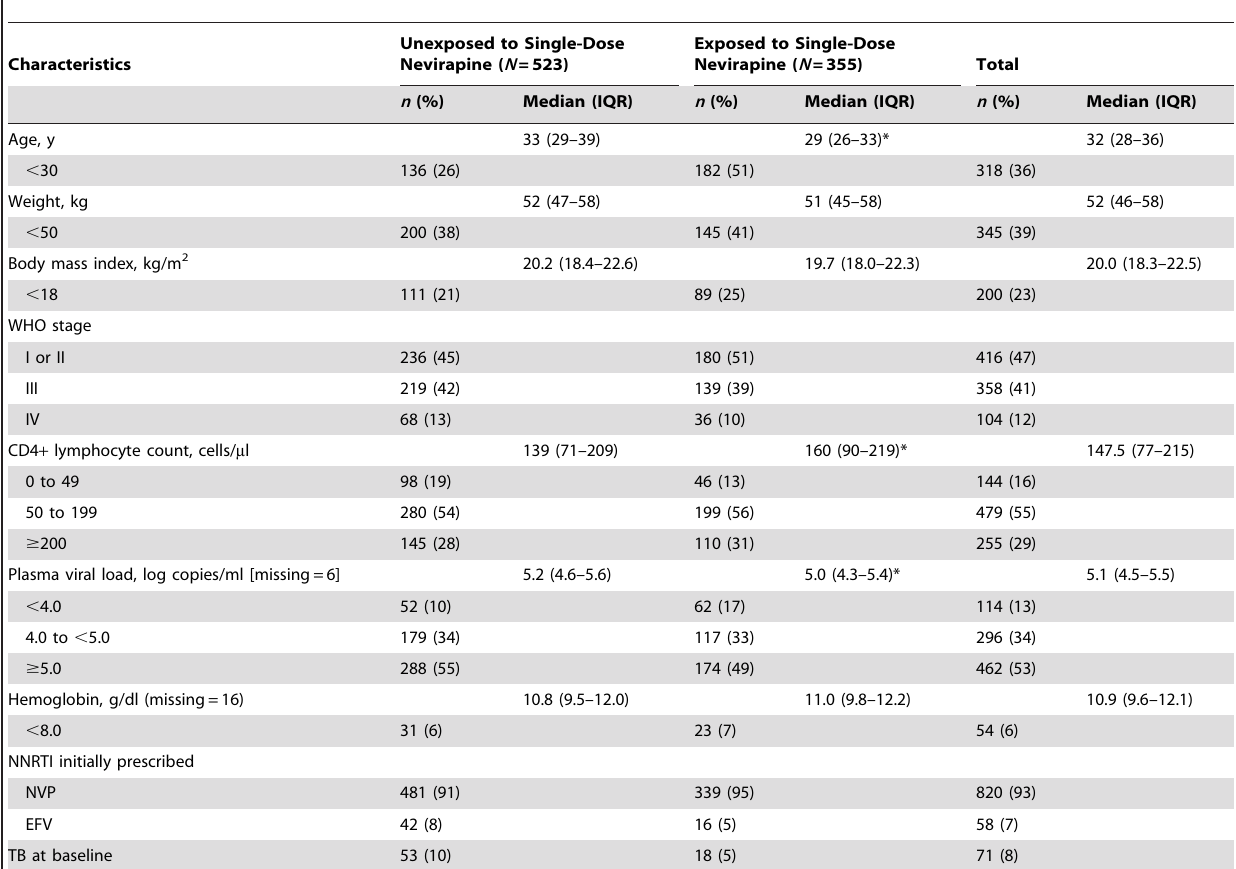
Table 2. Baseline characteristics of participants enrolled by prior exposure to single-dose nevirapine in the NNRTI Response Study—Zambia, Kenya, Thailand